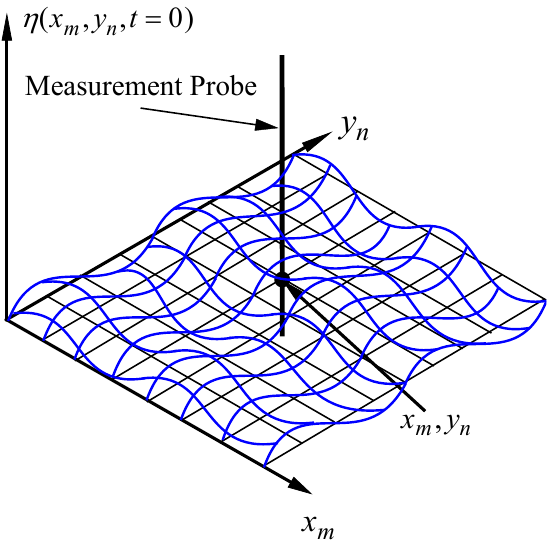
Figure 18. Ocean surface wave elevation in two dimensions at an instant in time, η ( x m , y n , t = 0 ) , on a grid of coordinate points ( x m , y n ) , with spatial resolution ( ∆ x , ∆ y ) .